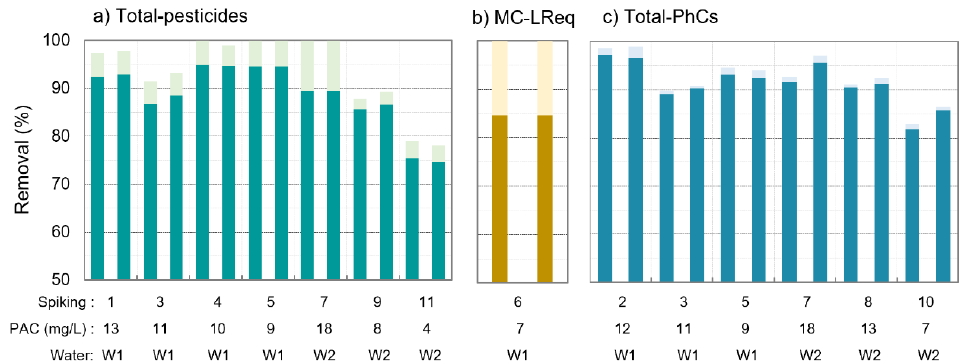
Figure 2. Removal of total-pesticides ( a ), microcystin-LR equivalent ( b ) and total-pharmaceuticals ( c ) by PAC/(Alum)/MF in each of the 11 spiking trials (2 samples per spiking; due to some microcontaminants’ concentrations < limit of quantifi- cation (LOQ), removals ranged between the values computed with LOQ for those microcontaminants, represented in darker colours, and values computed with 0 µg/L, in lighter colours).